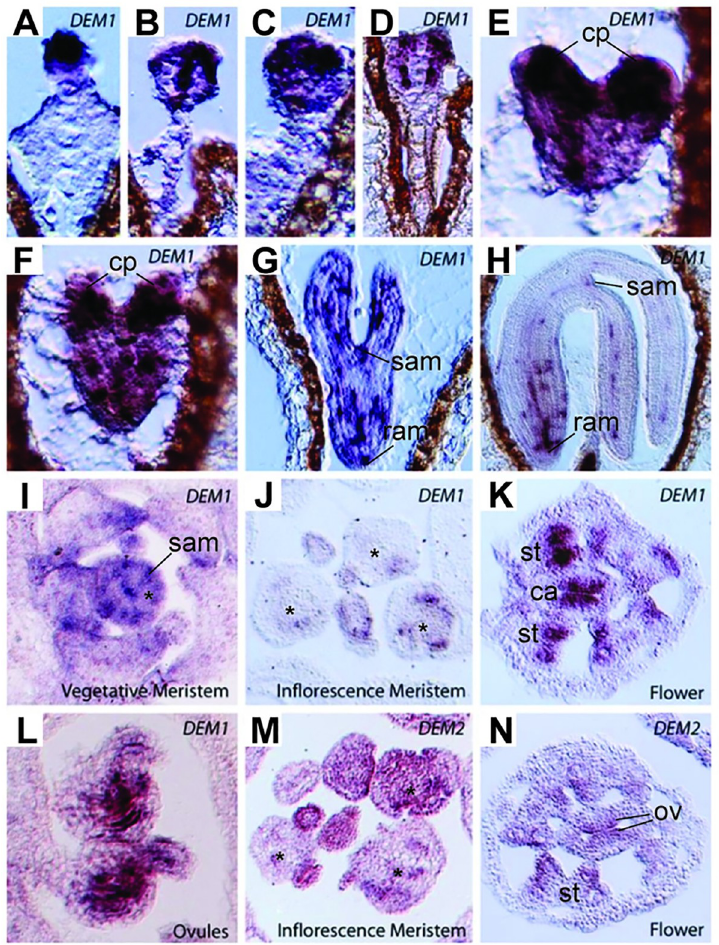
Fig 3. DEM1 and DEM2 mRNA expression detected by in situ hybridization in developing embryos and post- embryonic shoot tissues of Arabidopsis ecotype Ws-0. (A-H) Punctate expression of DEM1 in developing embryos. (A-D) Globular stage. (E-F) Heart stage. (G) Torpedo stage. (H) Maturing embryo. (I-J) DEM1 expression in shoot apices is not as clearly punctate as in developing embryos but is clearly expressed in vegetative shoot apical meristem and in some dividing cells. (I) Vegetative meristem. (J) Inflorescence meristem. (K-L) DEM1 expression can clearly be seen in sporophytic tissues of developing anthers and developing ovules. (K) Flower. (L) Ovules. (M-N) DEM2 is expressed in dividing cells of the inflorescence. (M) Inflorescence meristem. (N) Flower. cp, cotyledon primordia; ram, root apical meristem; sam, shoot apical meristem; � , central zone of meristem; st, stamen primordia; ca, carpel primordia; ov, developing